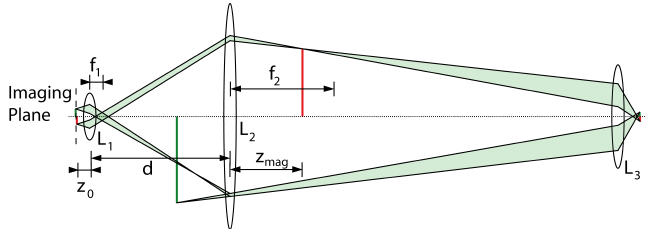
Figure 2. Schematic representation of two objects (red and green) magnified by a two-lens setup, with focal lengths f 1 and f 2 , placed in a distance of d > f 1 + f 2 relative to one another. The original small red and green objects in front of lens L 1 are reconstructed by a RELPH setup into the imaging planes also shown in Figure 1a. The red object is magnified and imaged as a real image in the distance z mag behind the second lens L 2 , while the green one is imaged in front of L 2 as a virtual image. Note that the light converges towards the optical axis and the observer. This fact is important for holograms produced by SLMs with small diffraction angles to reduce the aperture of a potential observing lens L 3